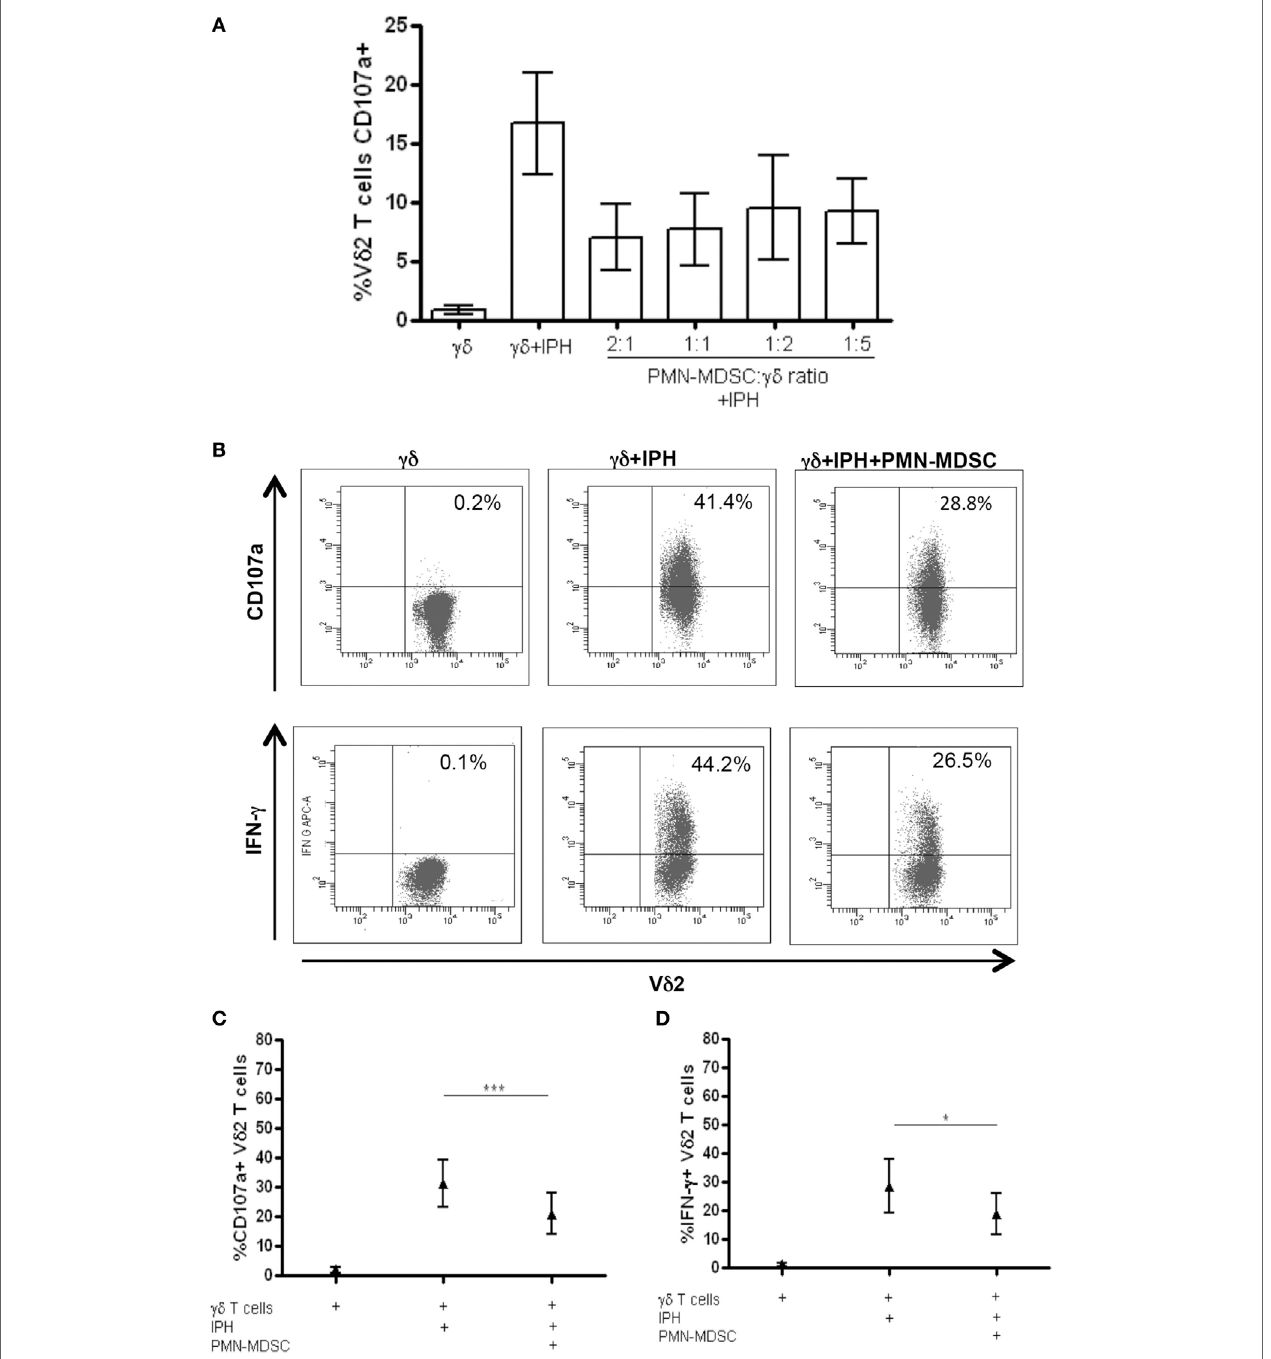
FigUre 2 | PMN-myeloid-derived suppressor cells (MDSC) inhibit IFN- γ production and CD107a expression by V δ 2 T cells . Purified γδ T cells were stimulated with IPH and IL-2 in the presence of PMN-MDSC and after 18 h IFN- γ and CD107a were evaluated by flowcytometry. (a) Titration of PMN-MDSC/ γδ T cells ratio tested by measuring CD107a expression on V δ 2 + T cells after IPH stimulation by flowcytometry. Results are shown as mean + SEM of two independent experiments. (B) Representative dot plots of IFN- γ production and CD107a expression by V δ 2 T cells. (c) Percentage of CD107a + V δ 2 T cells and (D) IFN- γ + V δ 2 T cells and in the indicated conditions. Results are shown as Mean + SEM of five independent experiments (* p < 0.05, *** p <